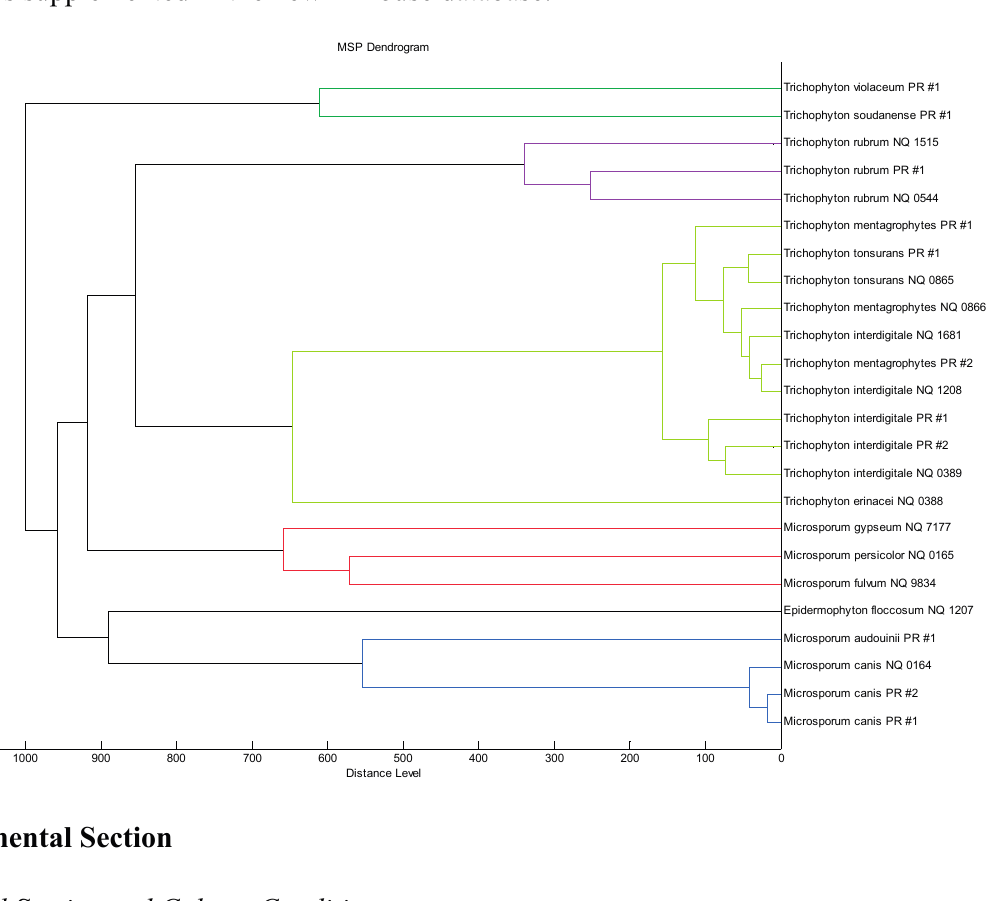
Figure 2. “Main spectra profiles”-based (MSP) dendrogram of the 24 dermatophytes strains supplemented in the new in-house